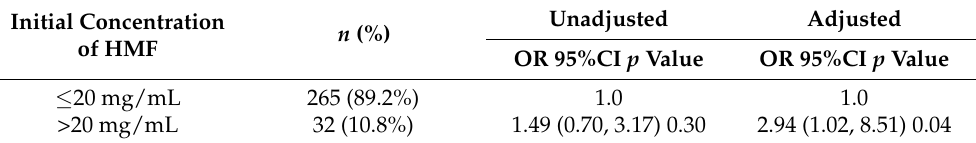
Table 5. Univariate and multivariate logistic regression to assess the association of initial concentra- tion of HMF with FI. Dates, 2015–2018.